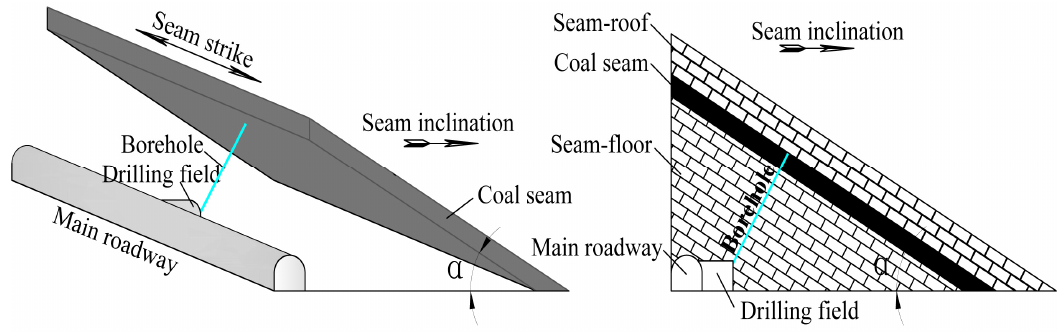
Figure 1. Relationship between the fracturing boreholes and coal